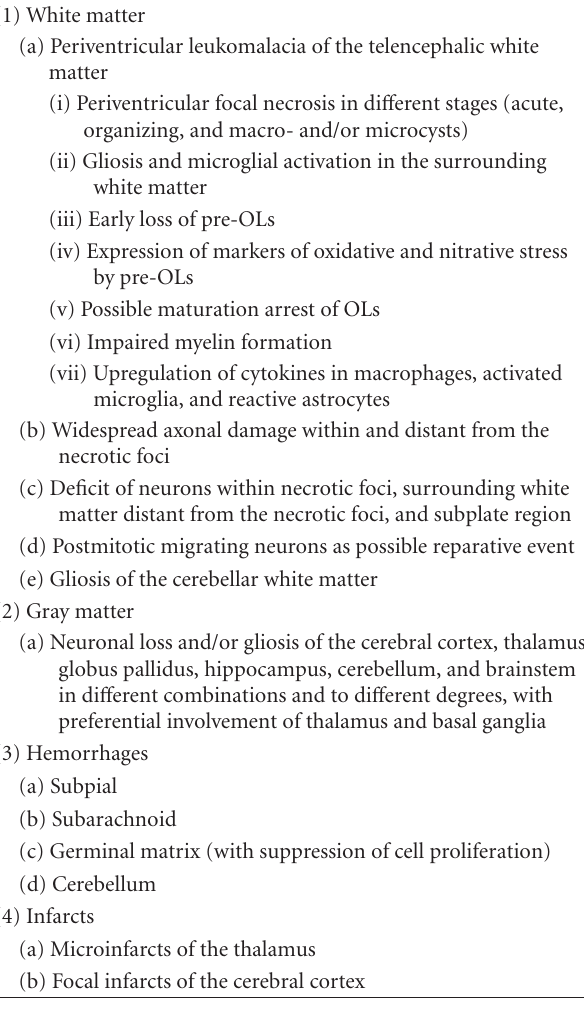
Table 2: Major histopathology features of the encephalopathy of prematurity in the human